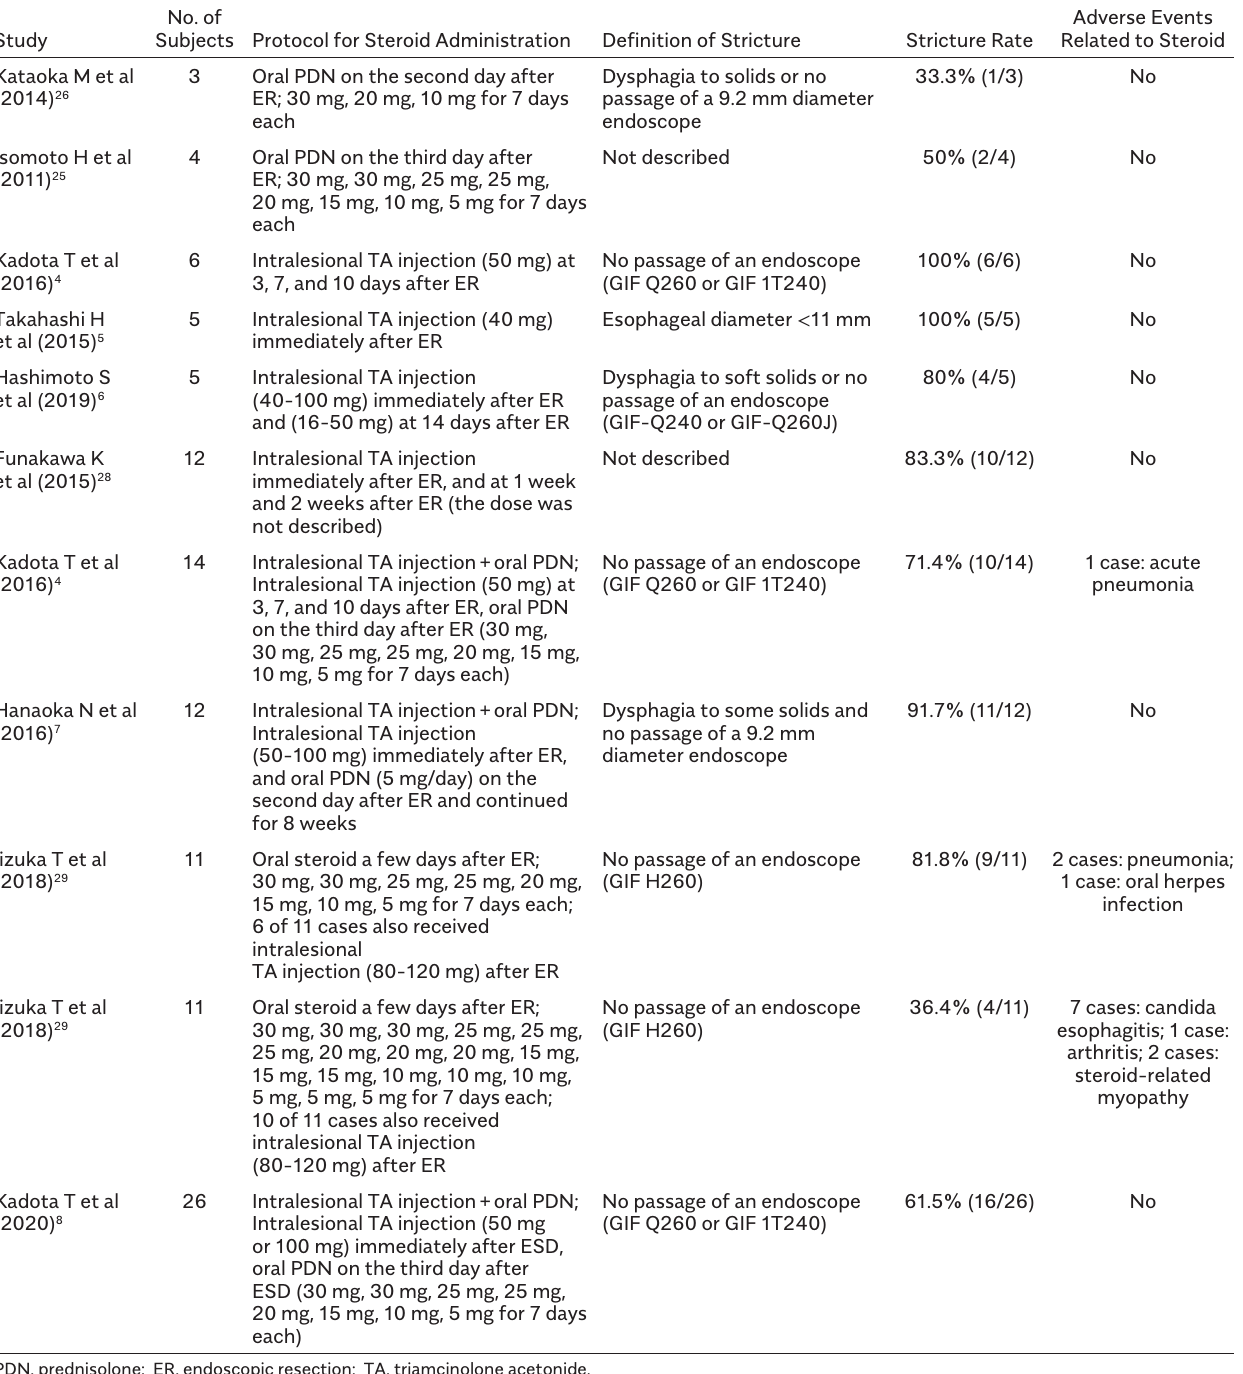
Table 1. Studies on Steroid Administration for Prevention of Esophageal Stricture After Whole Circumferential Endoscopic Resection No. of Study Subjects Protocol for Steroid